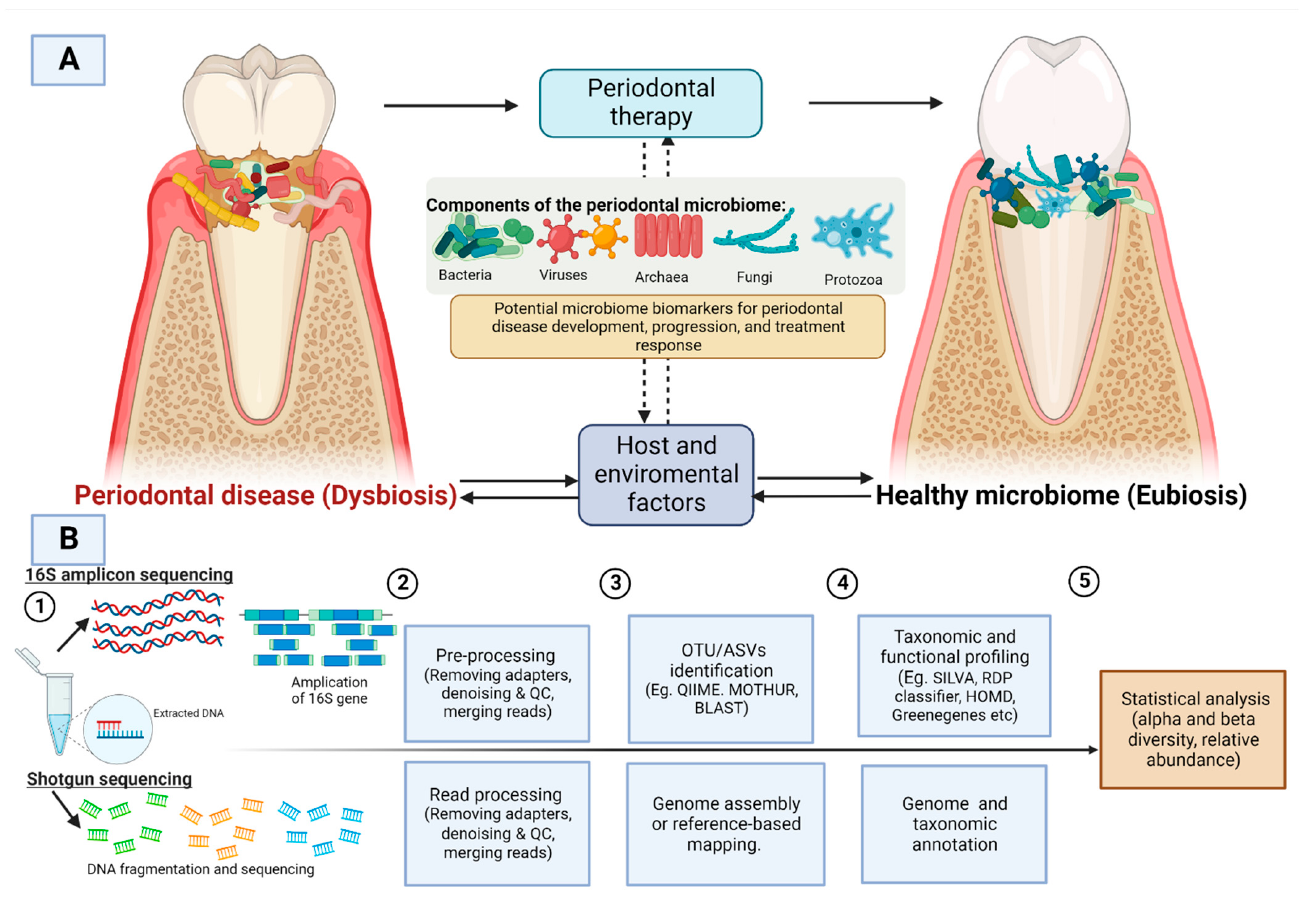
Figure 1. ( A ) Dysbiosis caused by the periodontal microbiome is influenced by various host and environmental factors. Periodontal intervention could alter the microbial composition from a state of dysbiosis (periodontal disease) to eubiosis (periodontally healthy) ( B ) A general workflow for 16S amplicon sequencing and shotgun sequencing. QC: quality control, OTU: operational taxonomic unit; ASV: Amplicon sequence variants. Image created with BioRender.com, accessed om 27 July 2022.